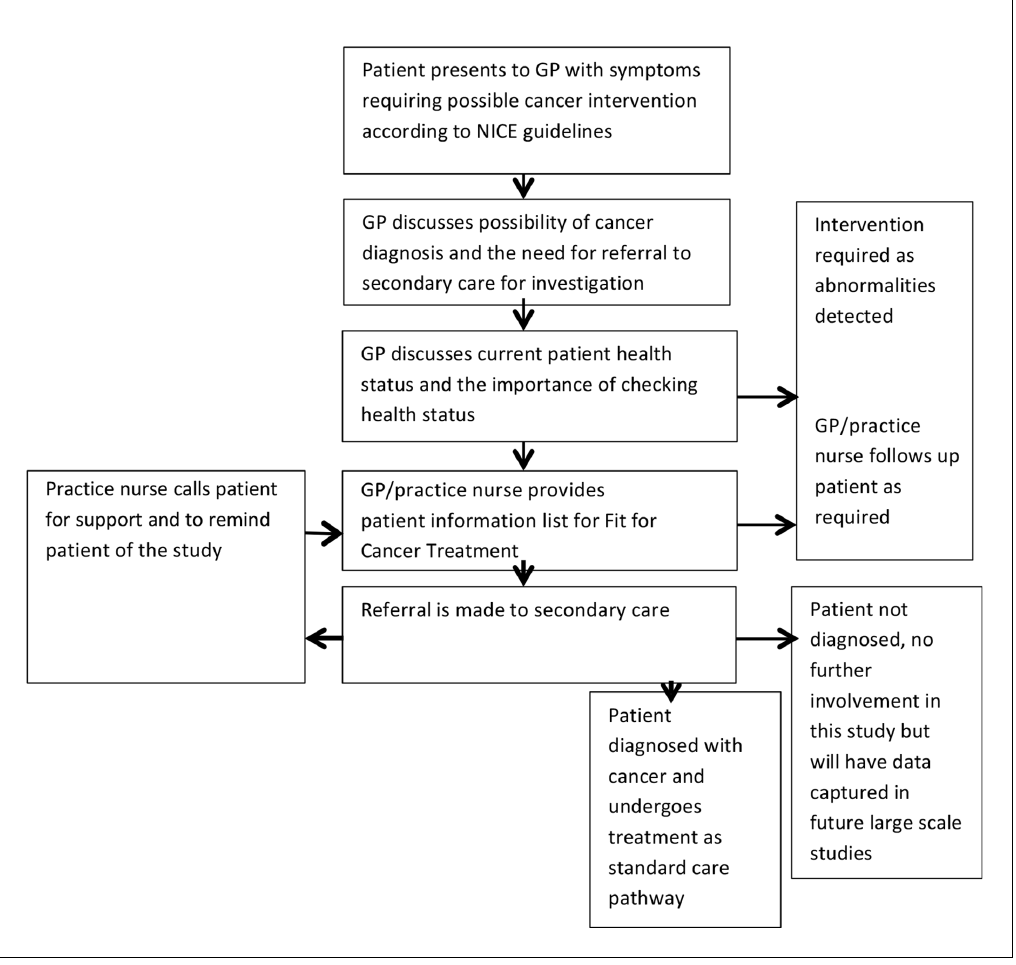
Figure 1. Patient flow